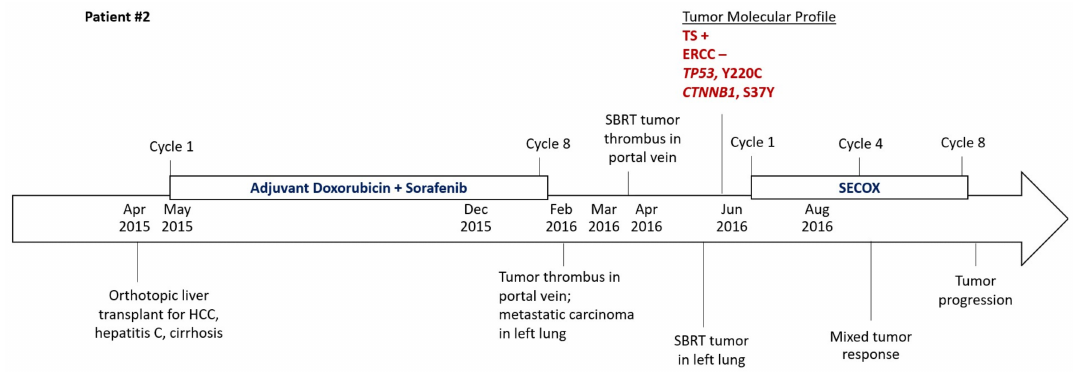
Figure 6. Timeline to illustrate the chronology of treatment and responses to treatment for patients #1 and #2 and the key data of their tumor molecular